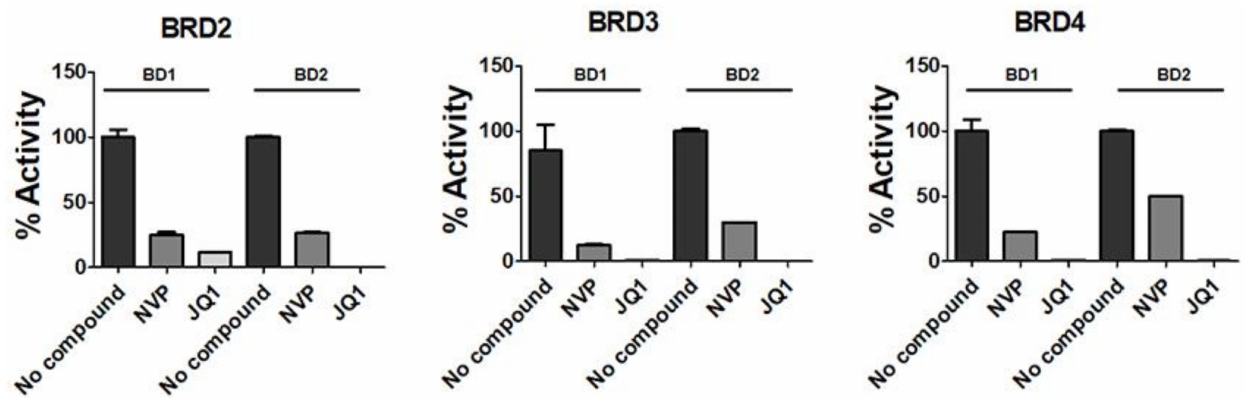
Figure 1. NVP inhibits the binding activity of bromodomains: effects of 10mM NVP on the binding ability of recombinant BD1 and BD2 domains of BRD2, BRD3 and BRD4 using the AlphaScreening assay ( n = 4). JQ1 (1 µ M) was used as a prototype of bromodomain